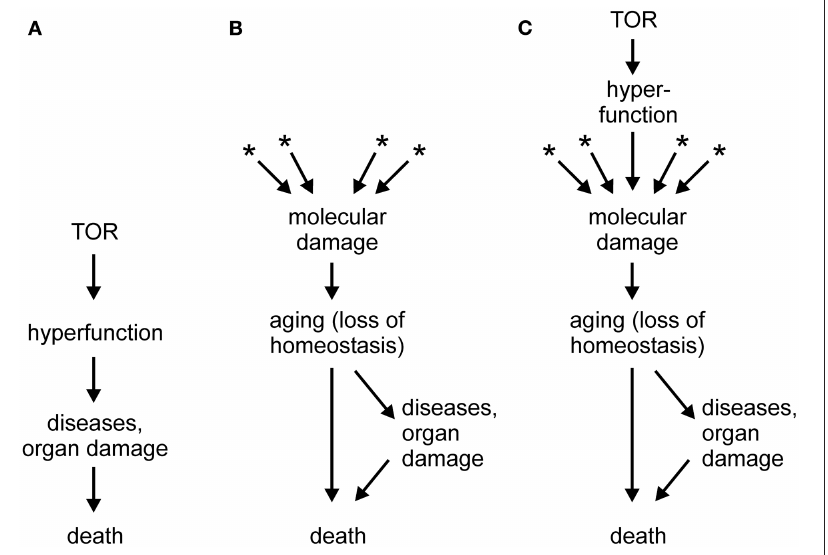
Figure 1 | (A) Scheme of the hyperactivity theory of aging (based on Blagosklonny, 2011a; Gems and de la Guardia, 2012). (B) Scheme of the molecular damage accumulation theory of aging; asterisks denote multiple sources of molecular damage, such as electrophilic stress, oxidative stress, protein misfolding, stochastic events, and others. (C) Scheme of a generalized molecular damage accumulation theory of aging which includes hyperfunction/hypertrophy as a source of destabilizing molecular damage which acts in addition to other sources of damage. See text for